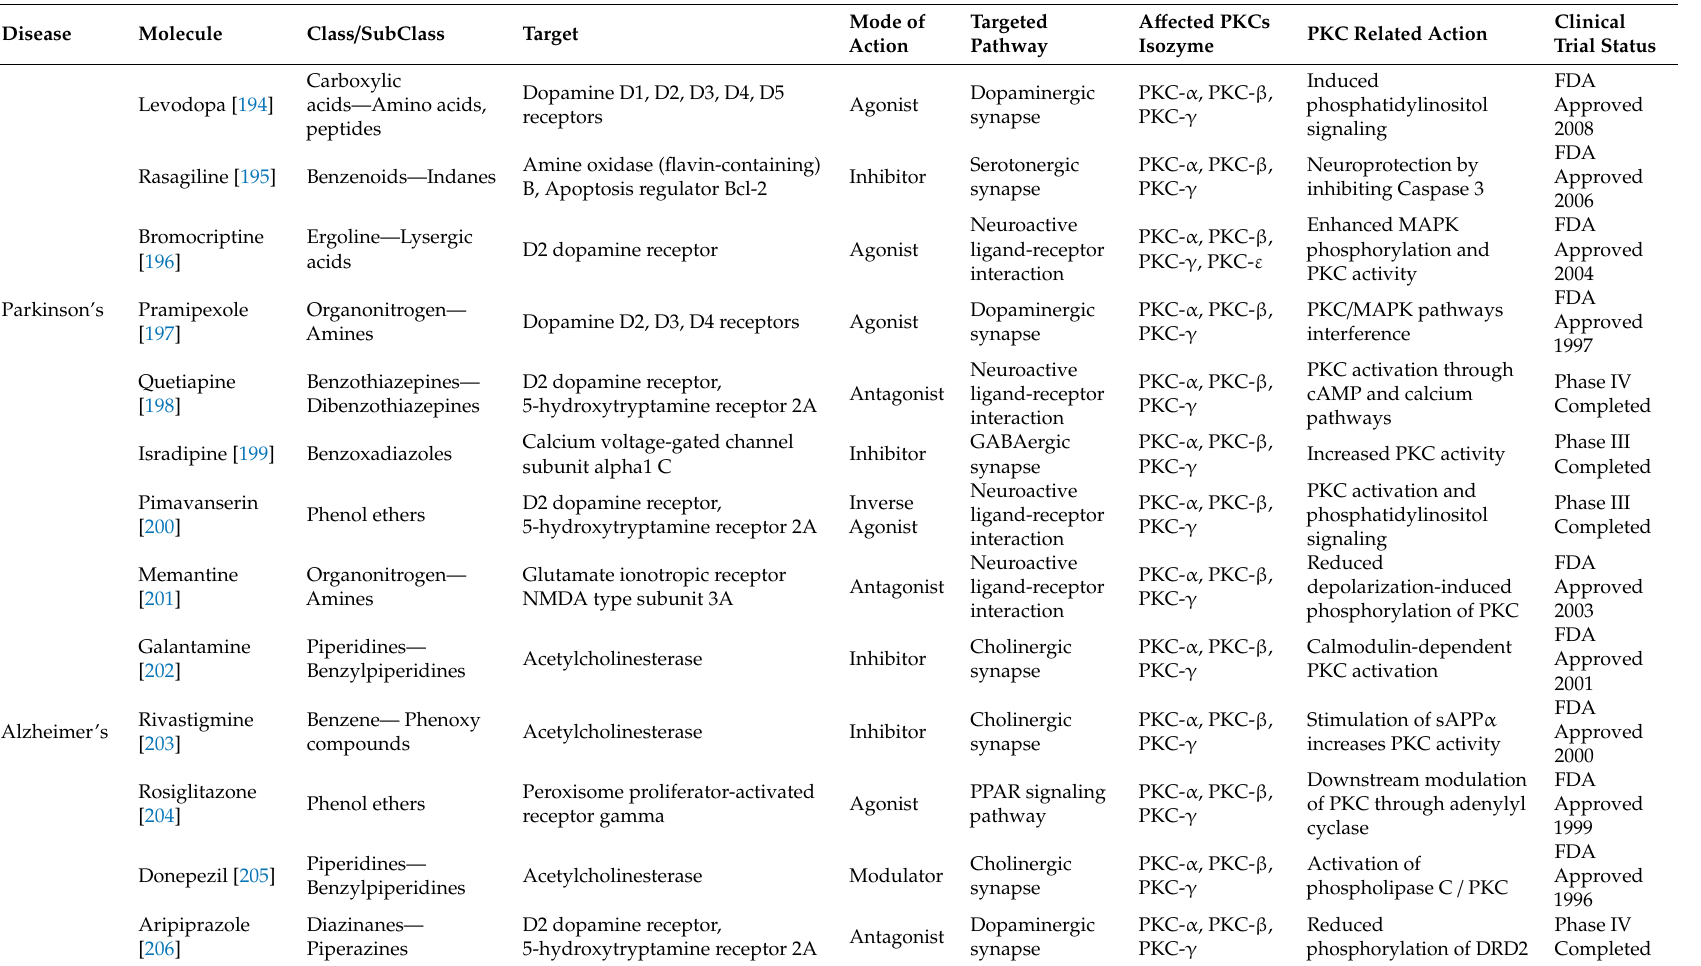
Table 2. Small molecule modulators and their targets involved in neurological diseases with respect to Protein kinase C (PKC) isozymes.